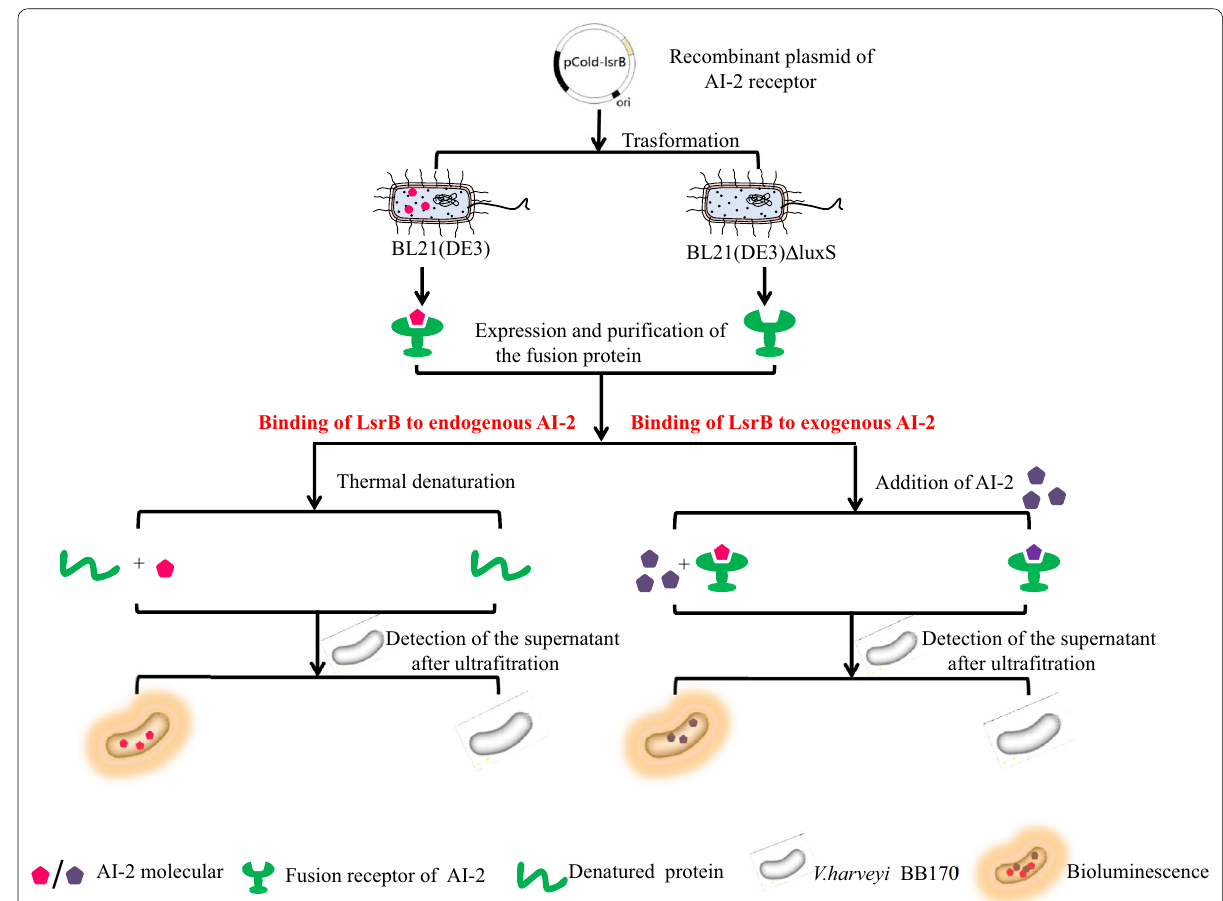
Fig. 7 Schematic chart of strategy for binding of LsrB to endogenous AI-2 or exogenous AI-2. The extent of LsrB binding to endogenous AI-2 was evaluated using an AI-2 assay, which showed that recombinant LsrB (BL21) bound to endogenous AI-2 (produced by wild-type strain BL21) and was released from LsrB (BL21) at 50 or 60 °C. However, since the luxS mutant BL21∆luxS did not produce endogenous AI-2, no AI-2 could be released from the recombinant LsrB (BL21∆luxS). The combination of endogenous AI-2 produced by BL21 (DE3), which is known to interfere with the bind- ing of AI-2 to LsrB (BL21), resulted in the loss in the ability of LsrB (BL21) to bind to exogenous AI-2. Hence, the BL21 (DE3) luxS mutant, which was incapable of producing endogenous AI-2, but could bind to exogenous